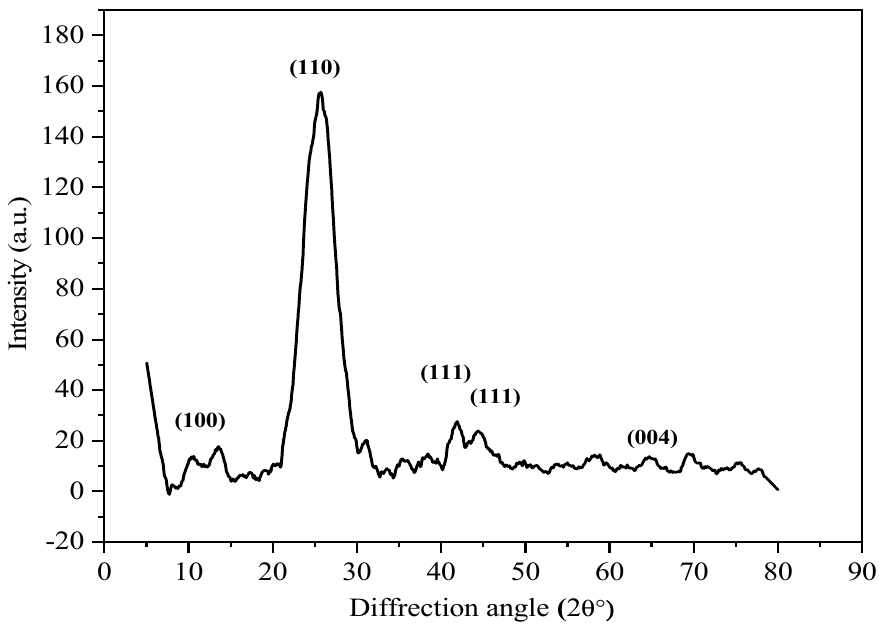
Figure 1. XRD of sulfonated tea waste catalyst.